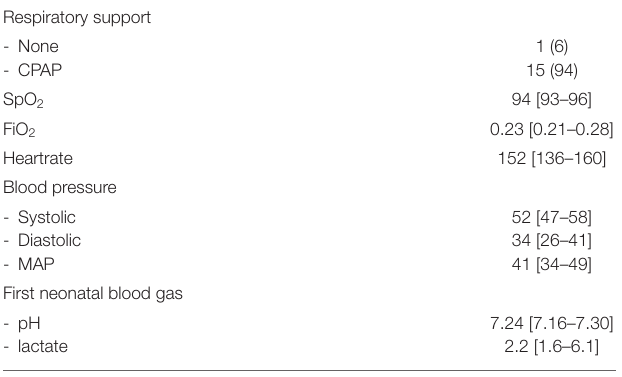
TABLE 2 | Neonatal variables during echocardiographic measurements, n = 16.